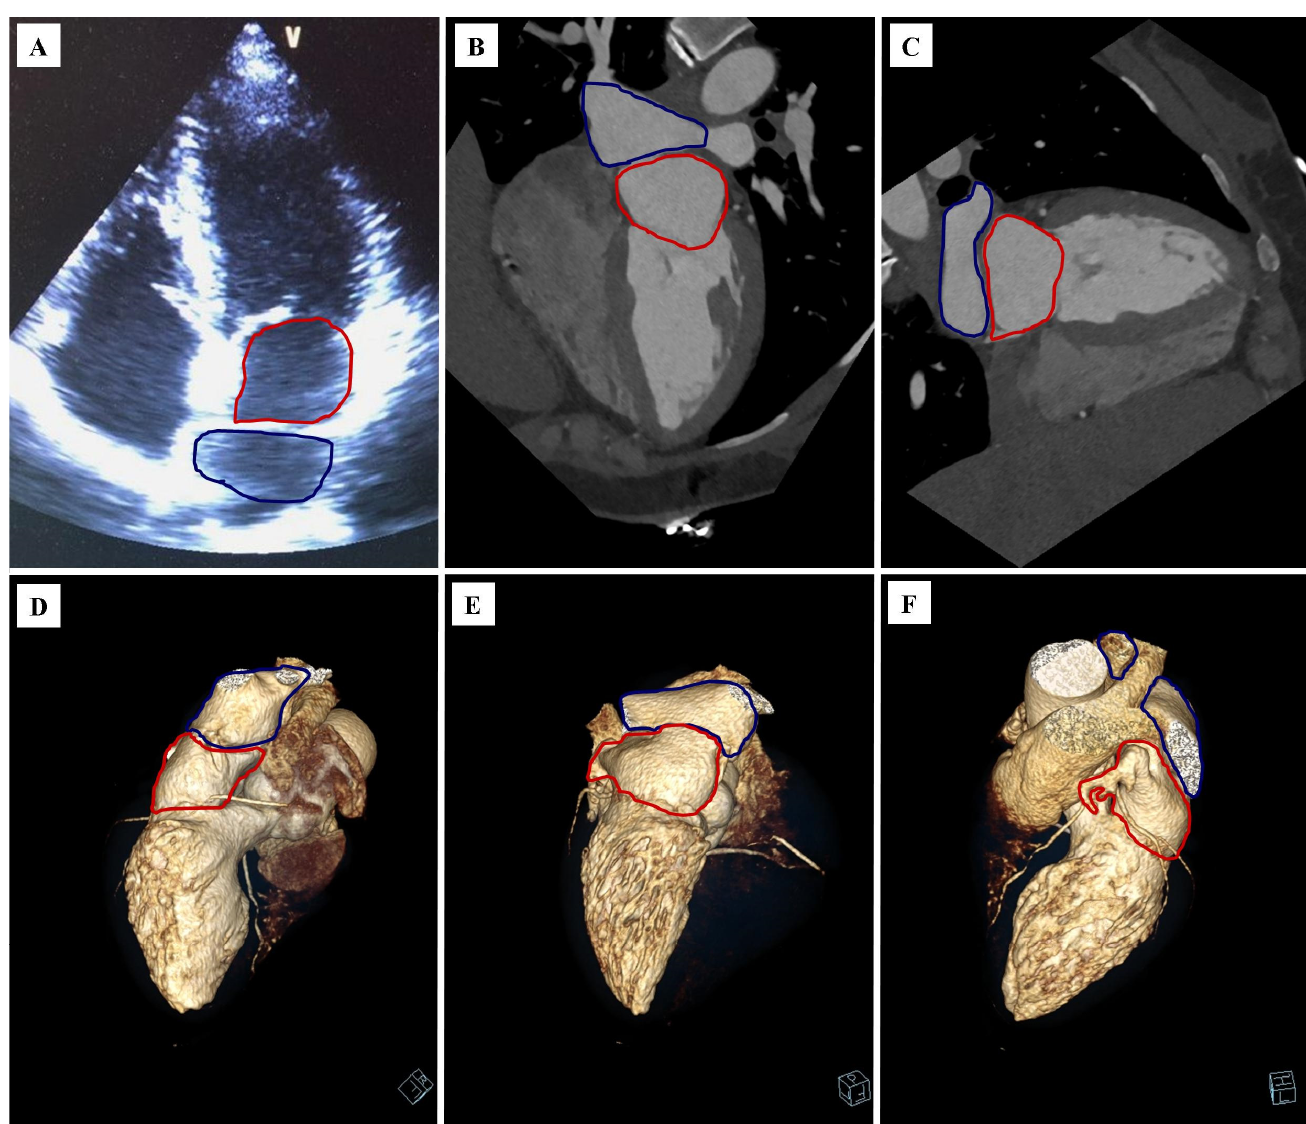
Figure 1. The cor triatriatum sinister. The proper atrium is marked with a red outline, while the accessory atrium is marked with a blue outline: ( A ) echocardiography, long axis, four-chamber projection; ( B ) cardiac computer tomography angiography (CCTA), multiplanar reconstruction (MPR), long axis, four-chamber projection; ( C ) CCTA, MPR reconstruction, long axis, two-chamber projection; ( D ) CCTA, volume rendering technique (VRT) reconstruction, right side view; ( E ) CCTA, VRT reconstruction, posterior view; ( F ) CCTA, VRT reconstruction, left side view.